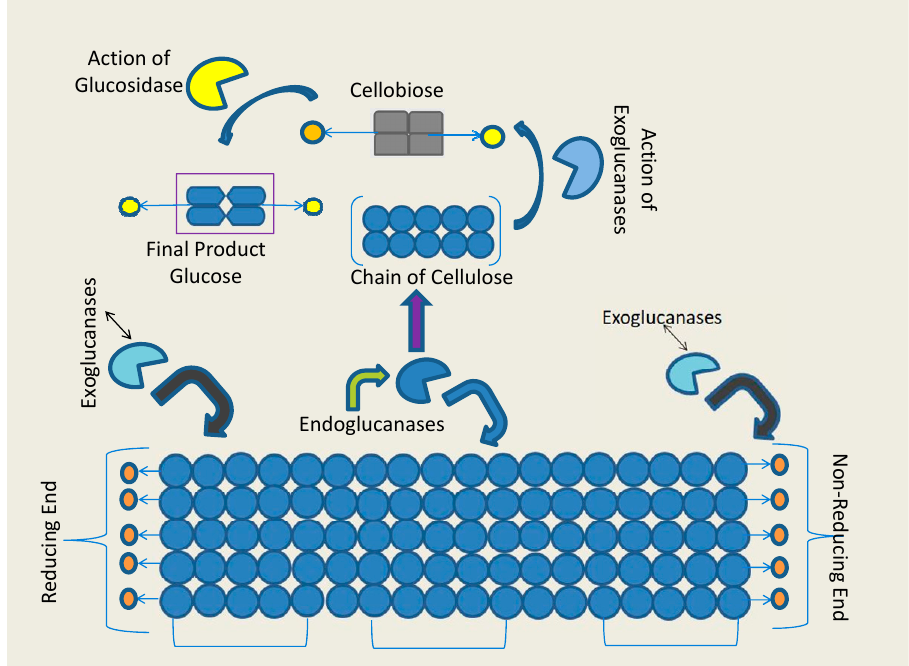
Figure 2. Hydrolysis of cellulose by the synergistic action of cellulases.